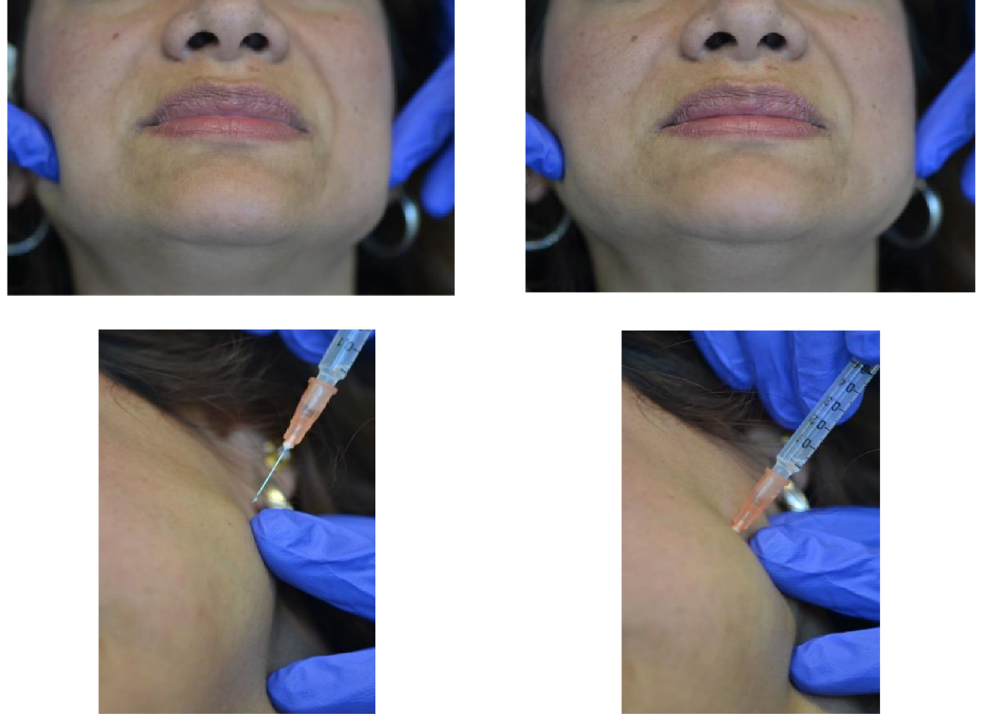
Fig. 4. Masseter injection in a patient with masseter hypertrophy (credit: Dr.